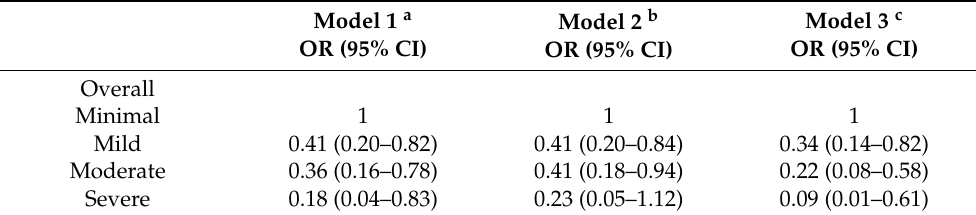
Table 2. Adjusted odds ratios (95% confidence interval) for prevalence of weekly sexual activity in relation to depression levels (reference subgroup: